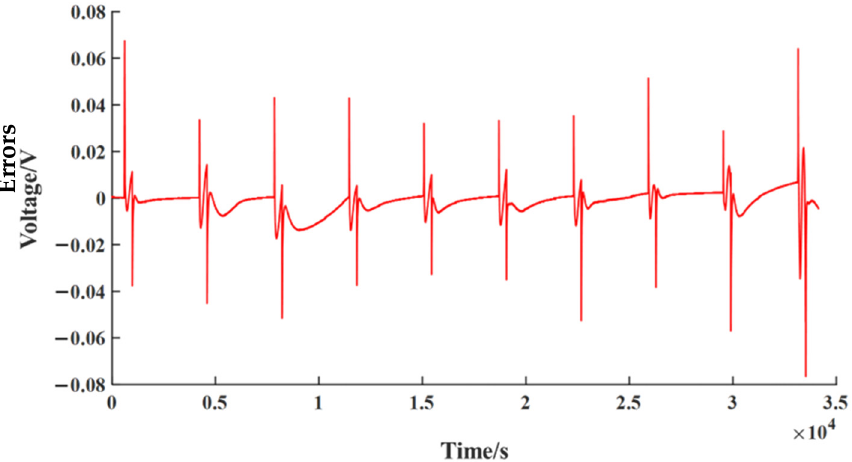
Figure 6. Error curve of response voltages between the Simulink simulations and experiments4. eXogenous Kalman filter to estimate SOC.